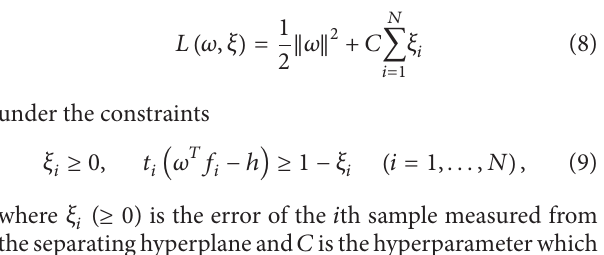
of the descriptor window is used to assign a weight to the magnitude of each pixel.